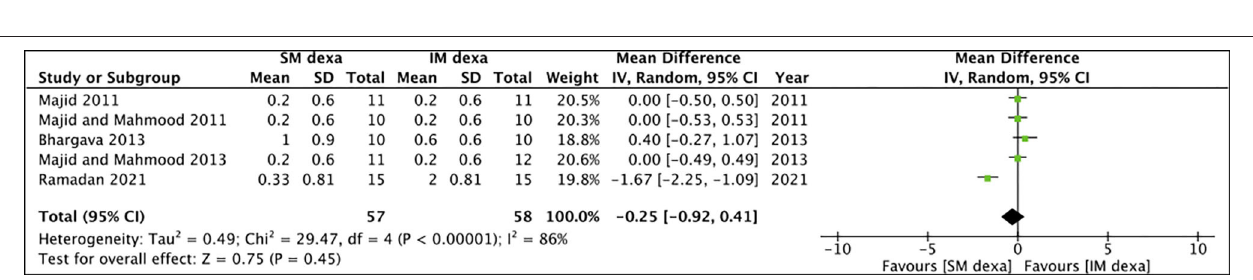
FIGURE 9 | Meta-analysis of late pain between SM and IM dexamethasone (dexa) for third molar surgeries.